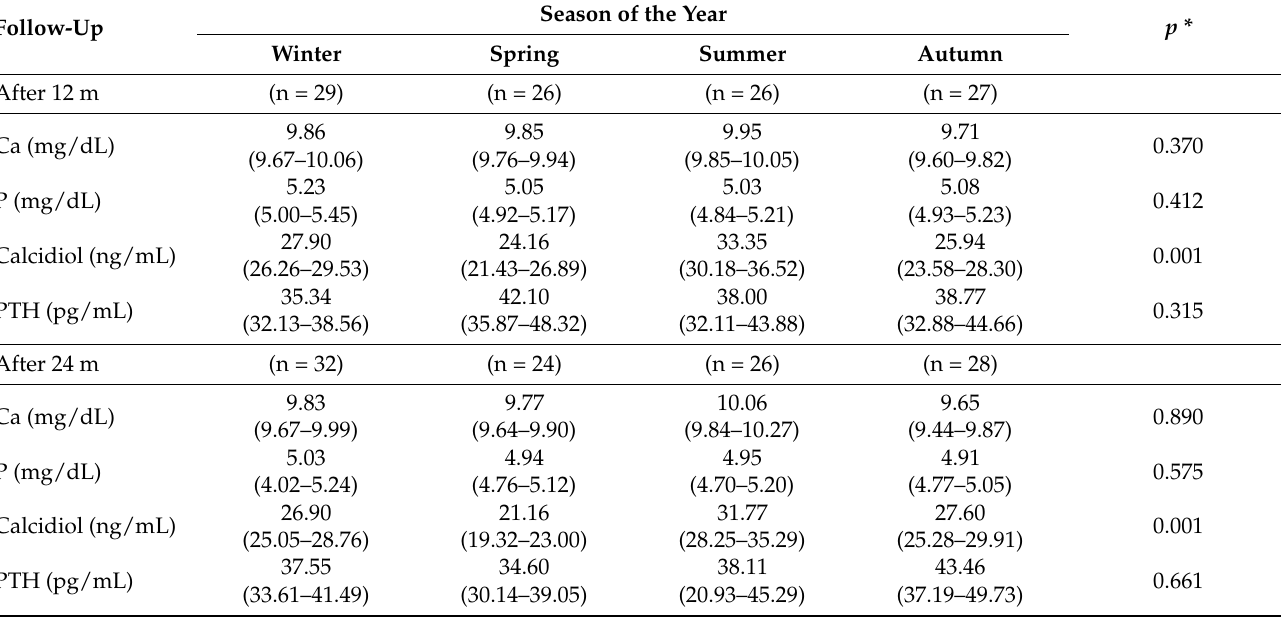
Table 3. Biochemical features in accordance to the season of the year in the GHD group along the treatment with rhGH (M, 95%